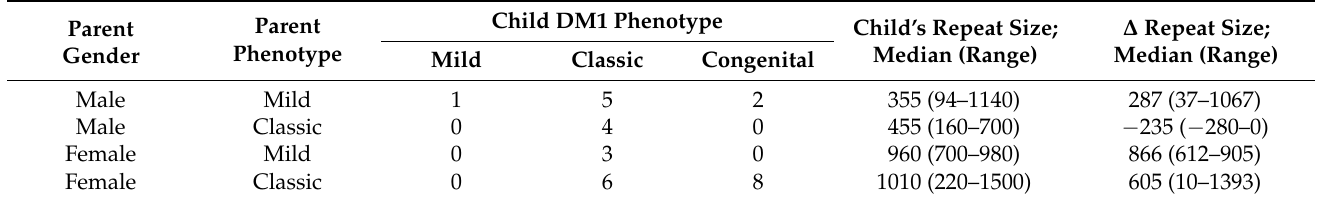
Table 2. DM1 phenotypes and CTG repeat size of the DMPK in the affected child according to gender and DM1 phenotype of the transmitting parent in 29 Korean parent–child matched pairs diagnosed with DM1.